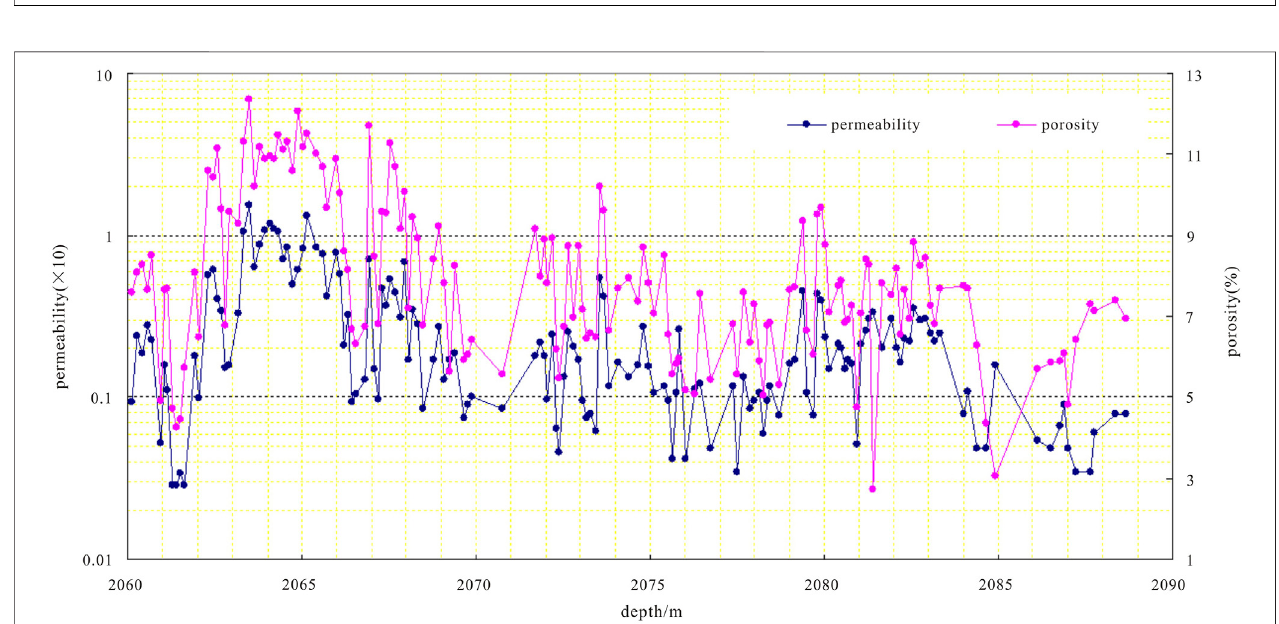
FIGURE 6 | Longitudinal variation characteristics of porosity and permeability of Chang 8 2 in 2,060- to 2,090-m section of X248 well.